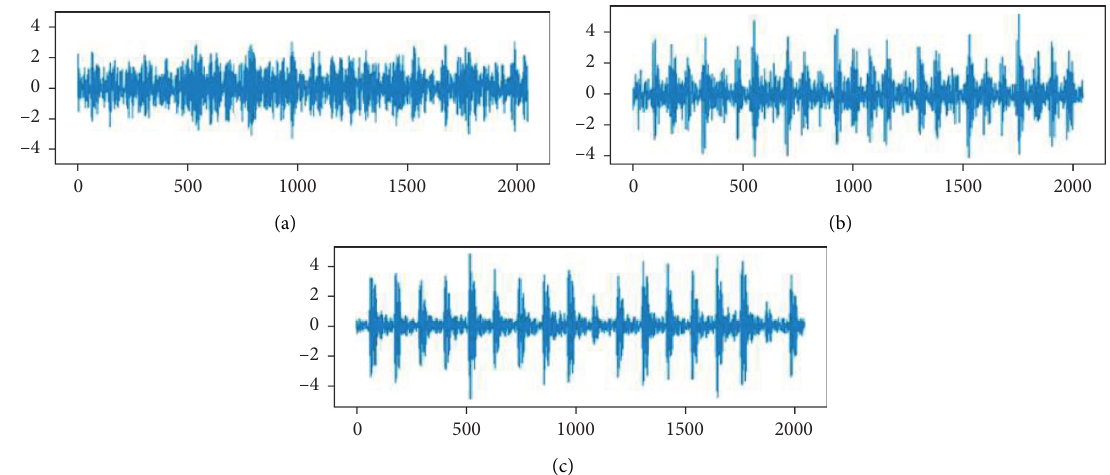
Figure 6: The standardization results of RE fault (a), IR fault (b), and OR (c) with 0.007-inch damage